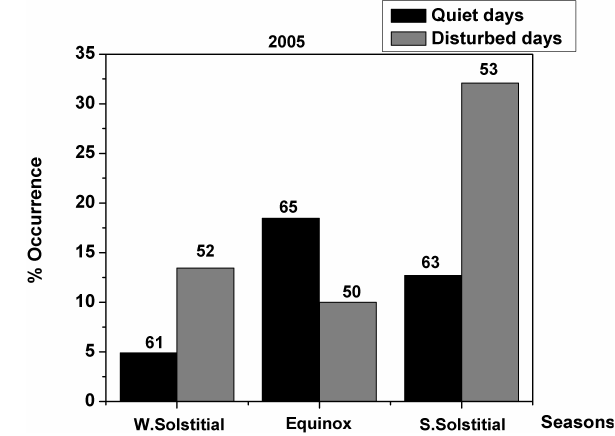
Fig. 3b. Same as for Fig. 3a, but for the solar minimum year of